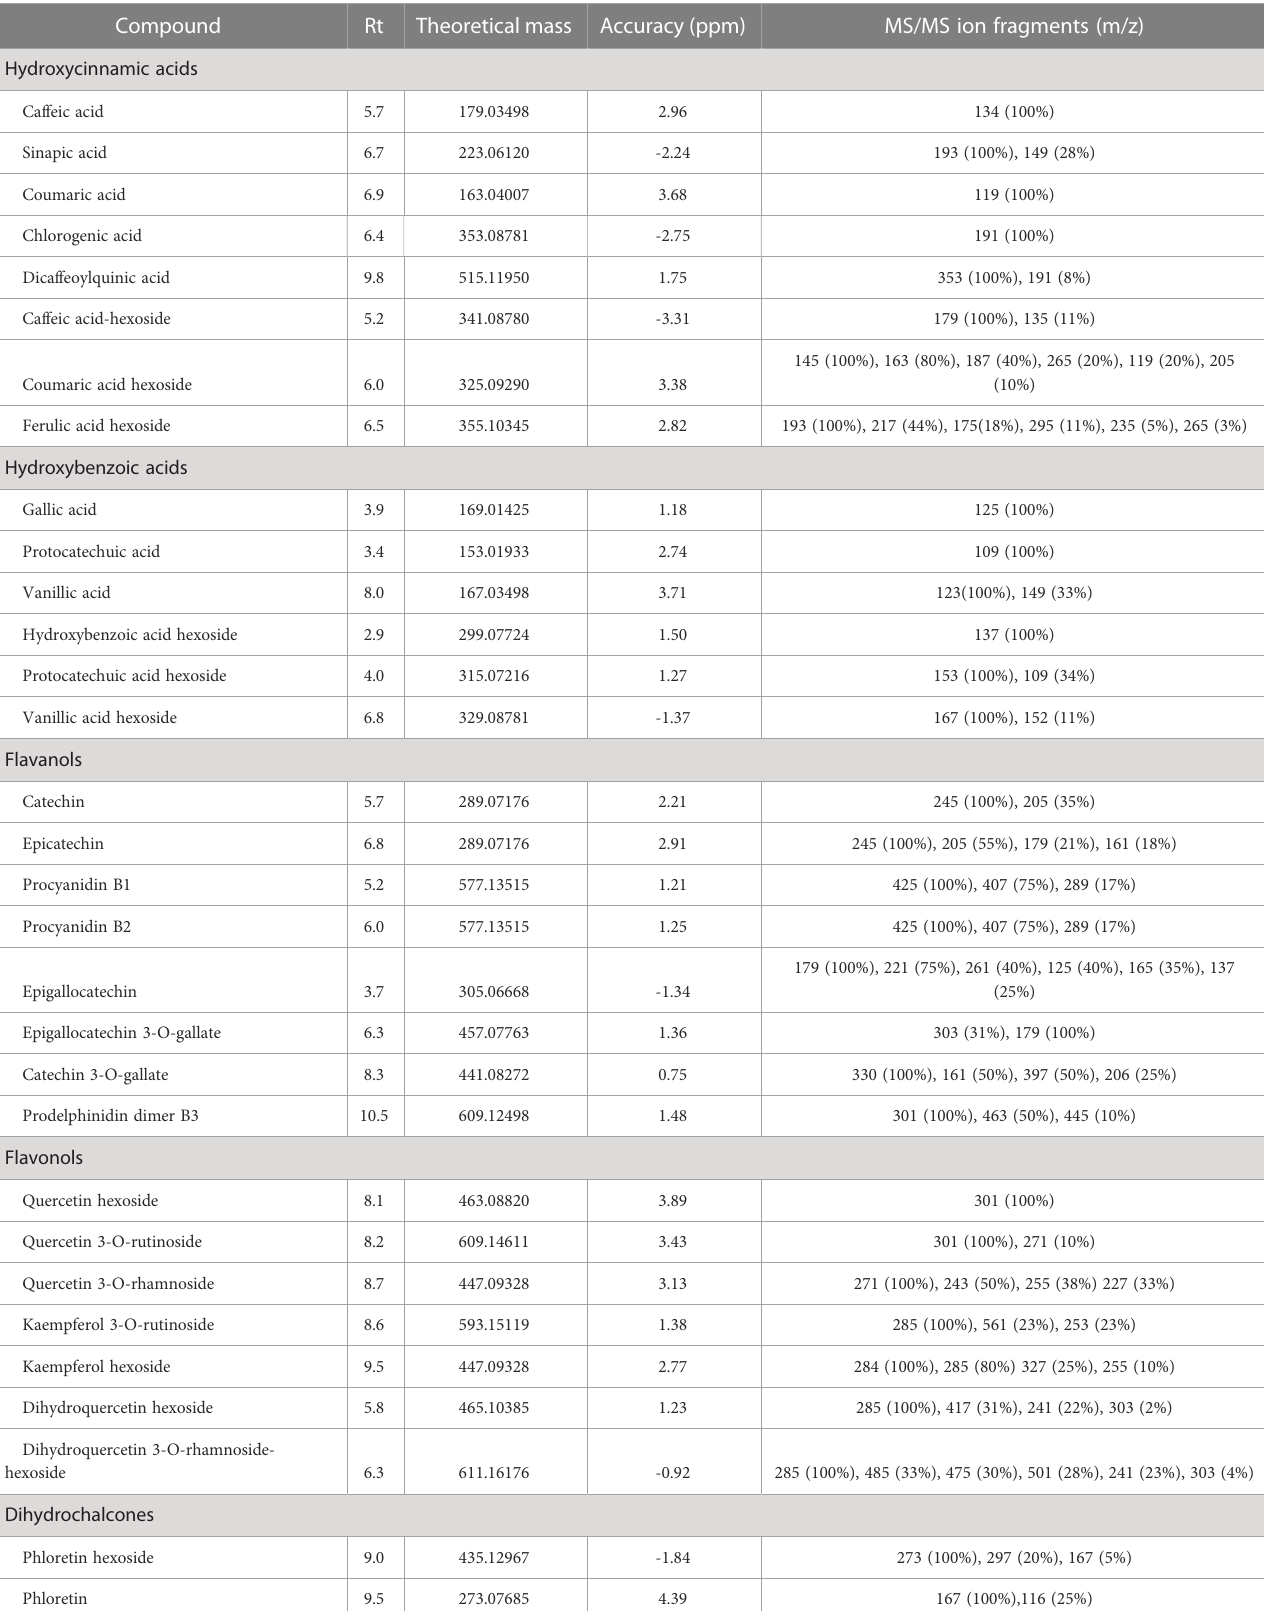
TABLE 2 Polyphenols identi fi ed in negative mode [M-H] - in the fruit of Kaki tipo, Cioccolatino, Vaniglia and Lampadina cultivars.